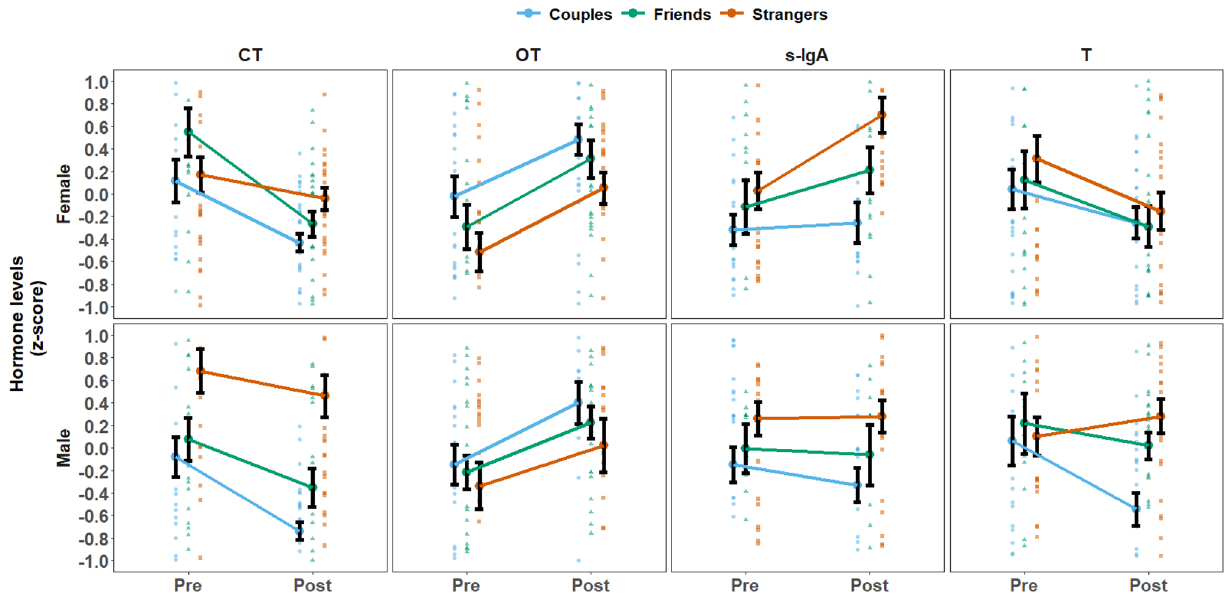
Figure 1. Group differences in CT, OT, s-IgA, and T. Groups are marked with shape and color (Couples — blue circle, Friends — green triangle, Strangers — orange square). Mean values are marked with bold square. Shaded dots are single participants values. Error bars reflects standard error from the